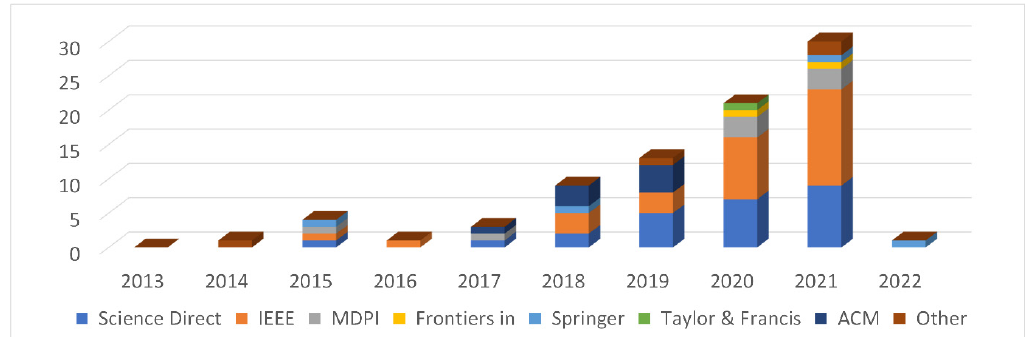
Figure 2. Articles included in the review. Table 1. Tier 1 categories.